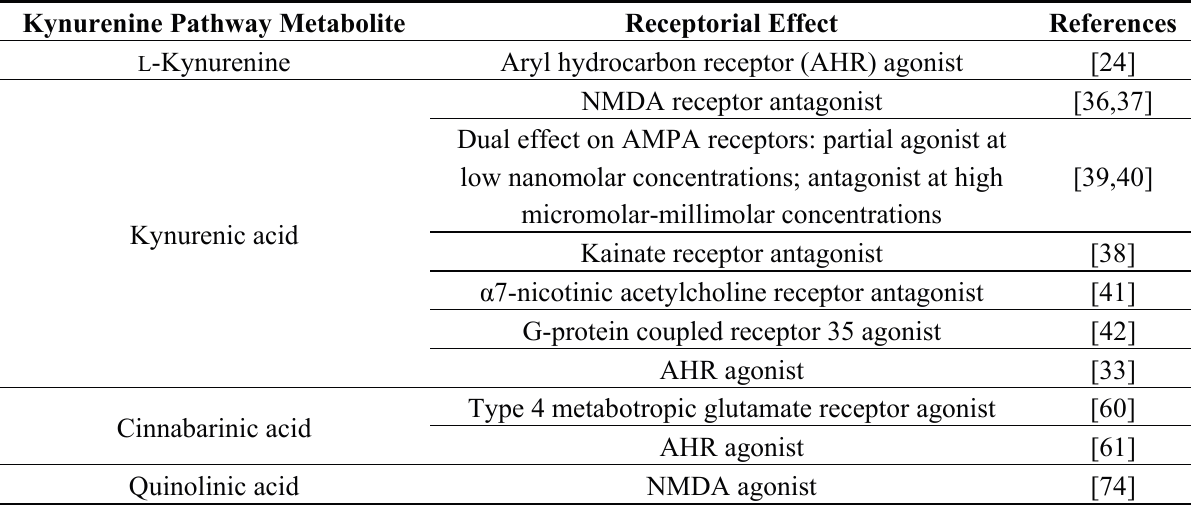
Table 1. Short summary of the direct receptorial effects of kynurenine pathway metabolites. Kynurenine Pathway